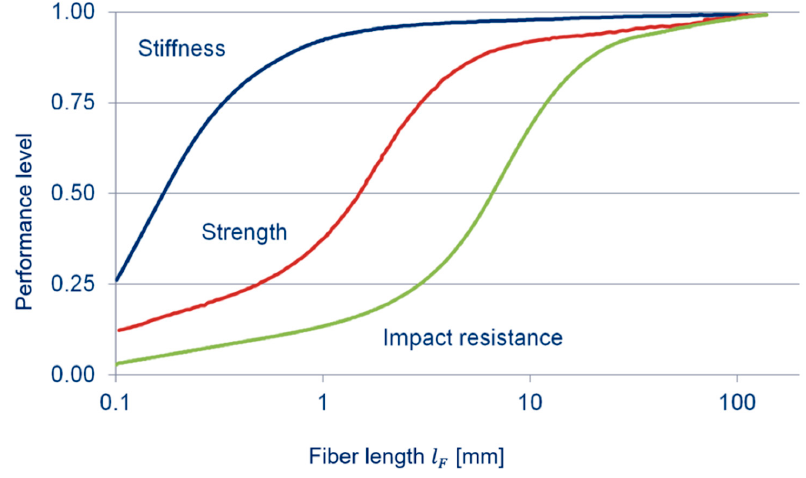
ff ness, tensile strength, and impact Figure 1. Influences of fiber length on stiffness, tensile strength, and impact strength. Figure 1. Influences of fiber length on sti